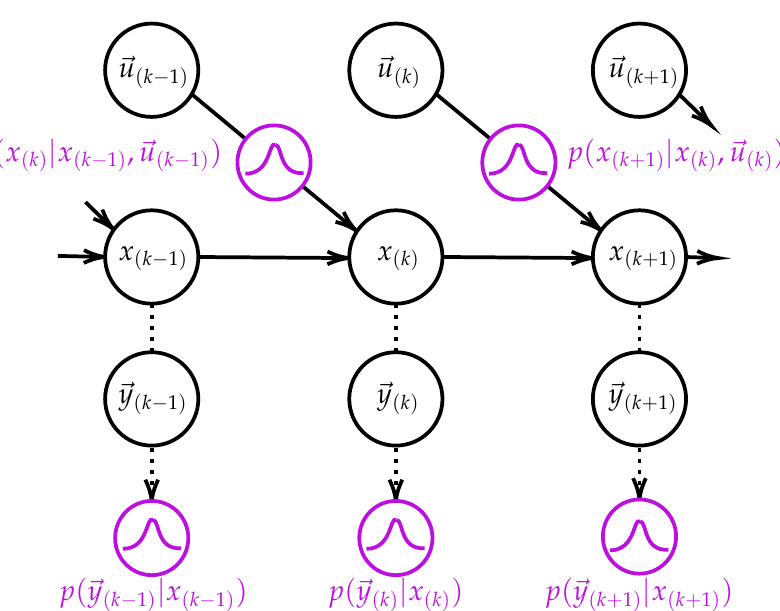
Figure 2. Bayesian network expressing conditional dependencies of an Input-Output Hidden Markov Model (IOHMM). The model is said ”hidden” because the states of the processes they model are not directly observable but inferred from contextual input (cid:126) u output (cid:126) y